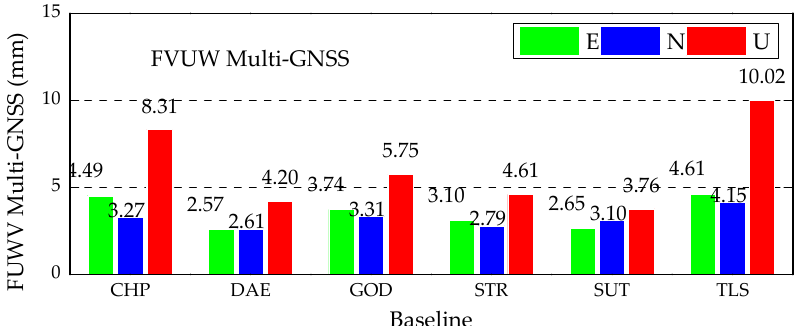
Figure 8. Time series of Multi-GNSS kinematic positioning errors of east ( top ), north ( middle ) and up ( bottom ) components for baseline SUT from DoY 183 to 186 in 2019. The reset appearing at the start of each day is caused by the independent daily process.